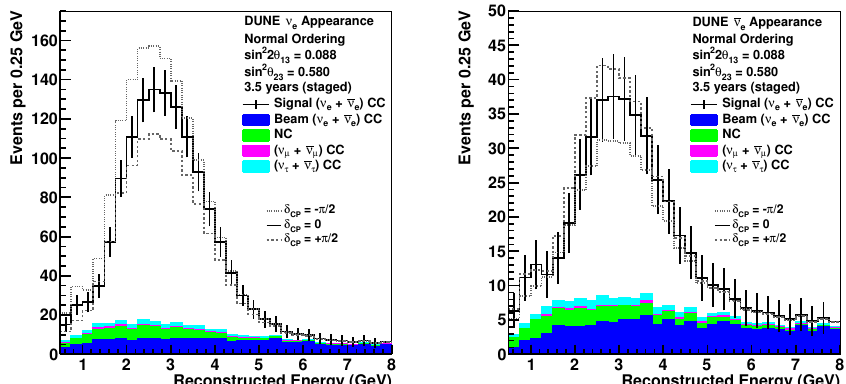
Figure 8. ν e and ¯ ν e appearance spectra: reconstructed energy distribution of selected ν e CC-like events assuming 336 kt-MW-years exposure, with equal running in the neutrino and antineutrino-beam mode. Statistical uncertainties are shown on the datapoints. The plots assume normal mass ordering and include curves for δ CP = − π /2,0, and π /2 [39].